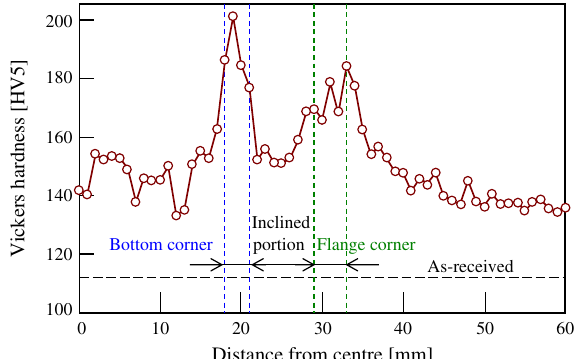
Figure 14. Distribution of Vickers hardness of cup after 3rd stage for h = 45 (cid:3) and s 2 = 22